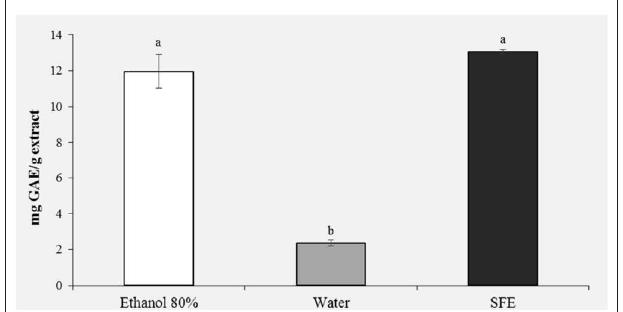
FIGURE 1 | Yield (g/100g) of honey bee pollen (HBP) extracts obtained with different solvents. Lowercase letters indicate significant differences between different solvents (a, b, c: P < 0.05).